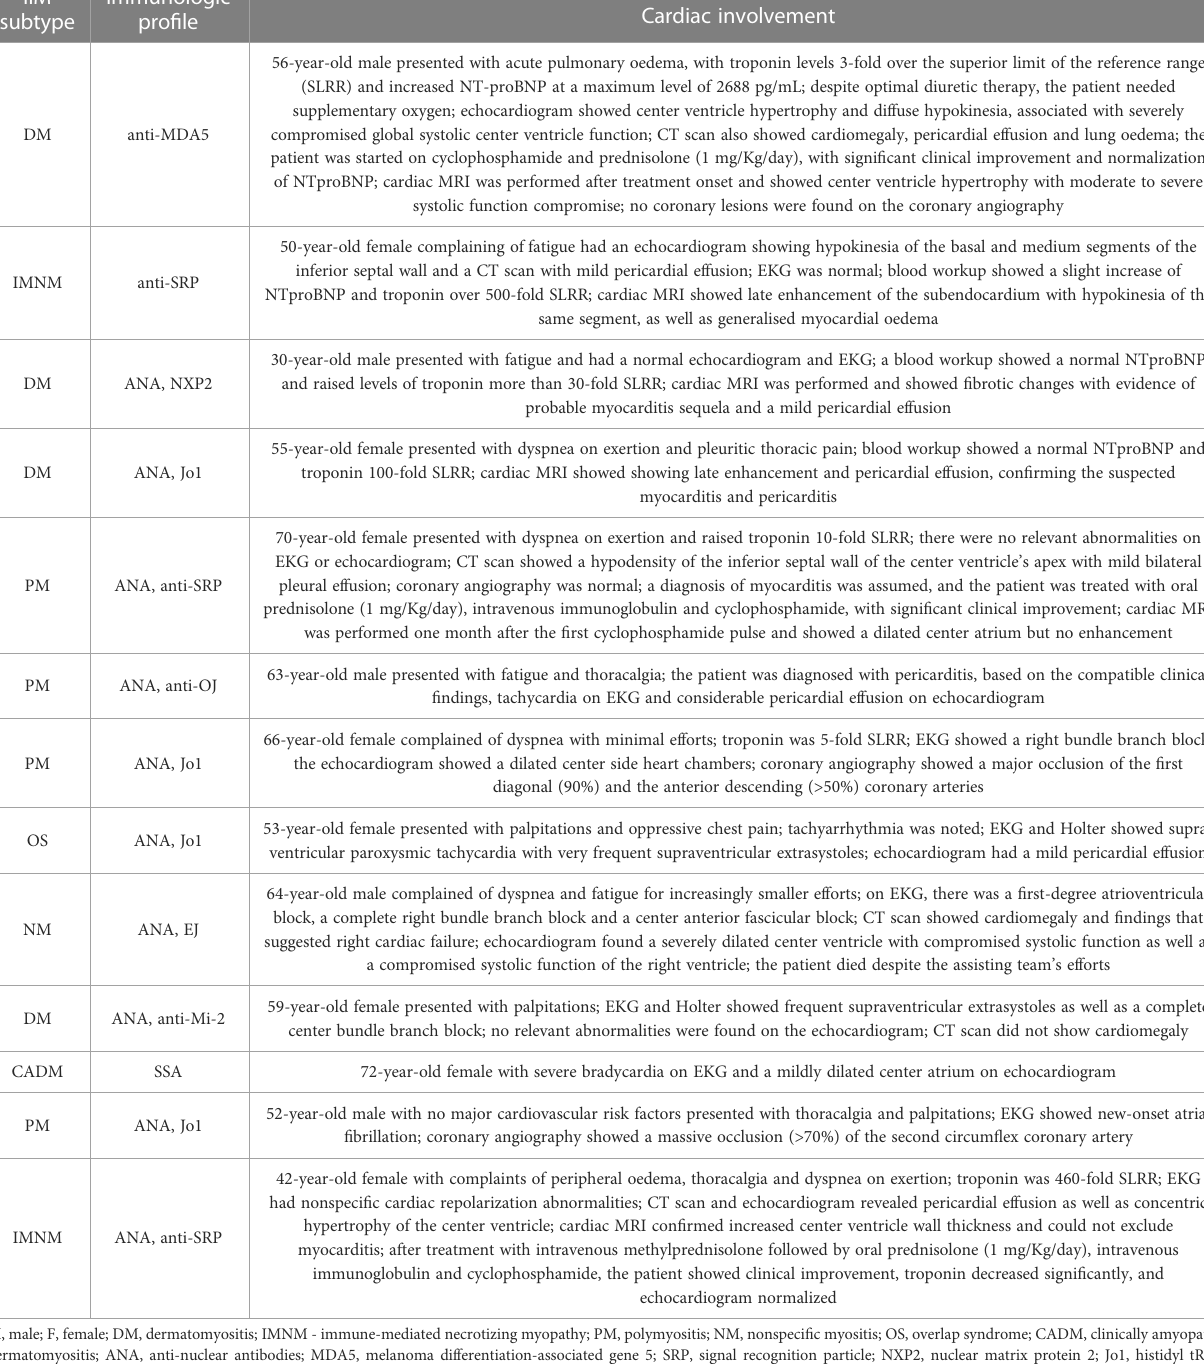
TABLE 2 Characteristics of the patients with cardiac